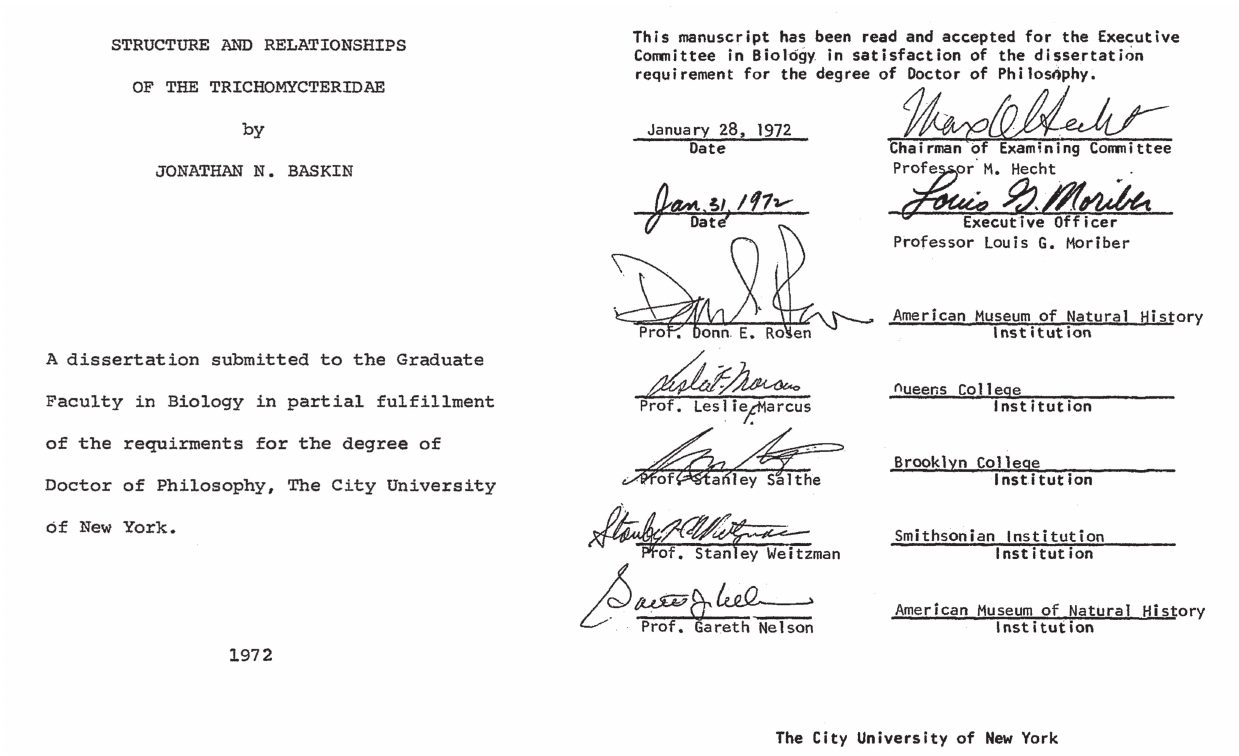
Fig. 1. Title page and examiners’ page of Baskin